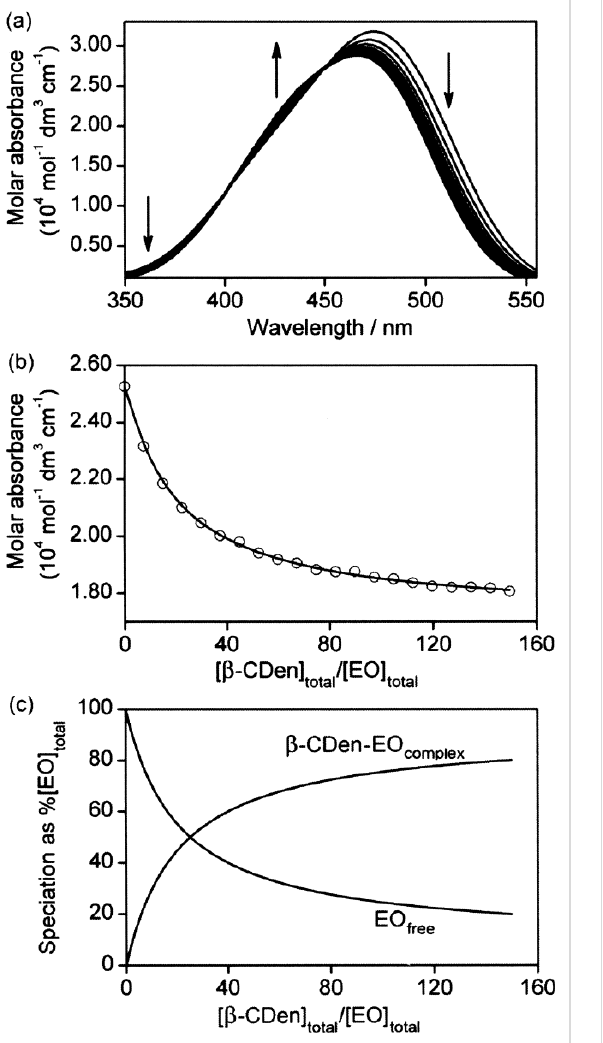
Figure 7: (a) Molar absorbance variation of 1.5 cm 3 of a EO solution ([EO] = 2.00 × 10 − 5 mol dm − 3 ) with 20 sequential additions of a PAA β - CDen solution (25 mm 3 each, 1.93 wt %, [ β -CDen] = 9.03 × 10 − 3 mol dm − 3 ) and a PAAADhn solution (25 mm 3 each, 0.98 wt %, [ADhn] = 3.00 × 10 − 3 mol dm − 3 ) at 298.2 K. All solutions were prepared in aqueous Na 2 HPO 4 /KH 2 PO 4 buffer solutions at pH 7.0 and I = 0.10 mol dm − 3 . The arrows indicate the direction of molar absorbance variation upon each addition of the PAA β -CDen and PAAADhn solutions. (b) Molar absorbance variation at 500 nm and the line representing the best-fit of an algorithm for a 1:1 host–guest com- plexation of EO by β -CDen substituents in the self-assembled PAA β - CDen/PAAADhn network over the wavelength range 475–525 nm. (c) Speciation plot with [EO] total = 100% as the ratio [ β -CDen] total /[EO] total increases. shown in Equation 1 and Equation 7. The K 11 for the